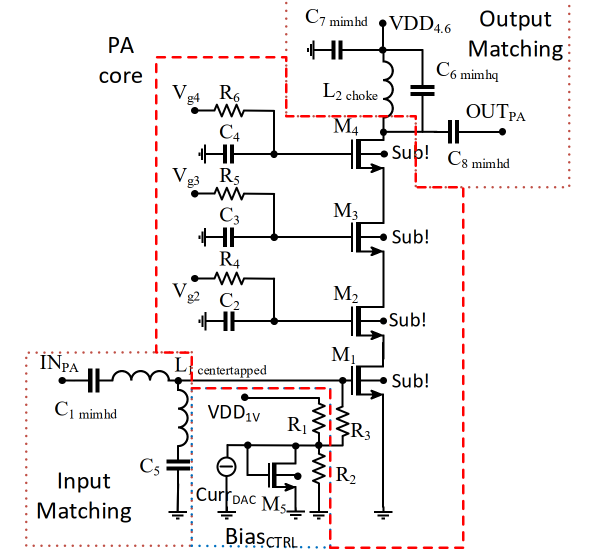
Figure 1. Schematic of the stacked PA.